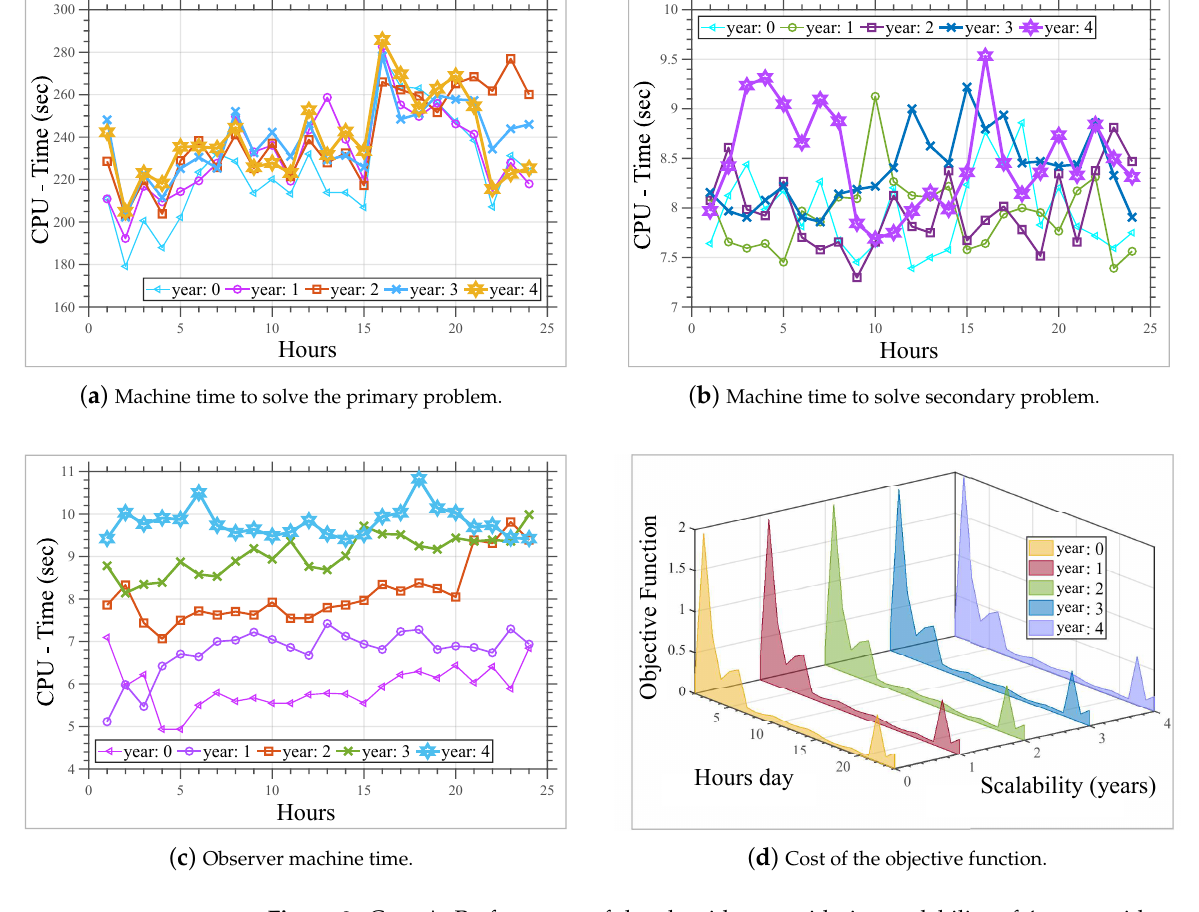
Figure 9. Case A: Performance of the algorithm considering scalability of 4 years with a growth rate of